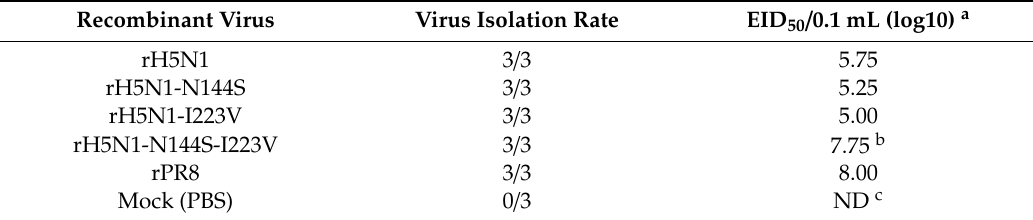
Table 5. Replication e ffi ciency of the H5N1 recombinant viruses in mice. Recombinant